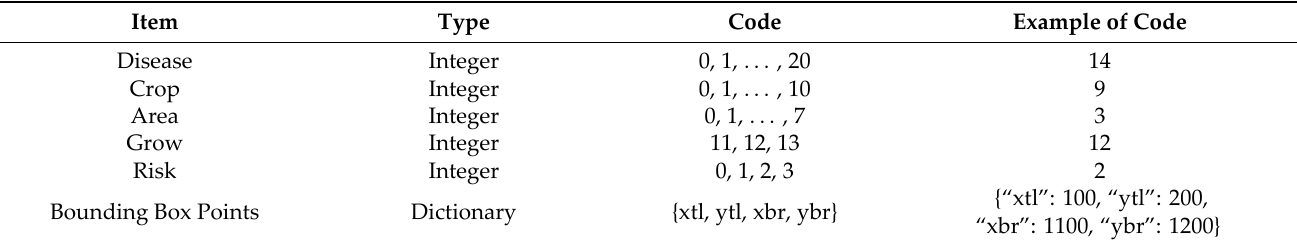
Table 1. Examples of Metadata Information Provided by AI‑Hub.